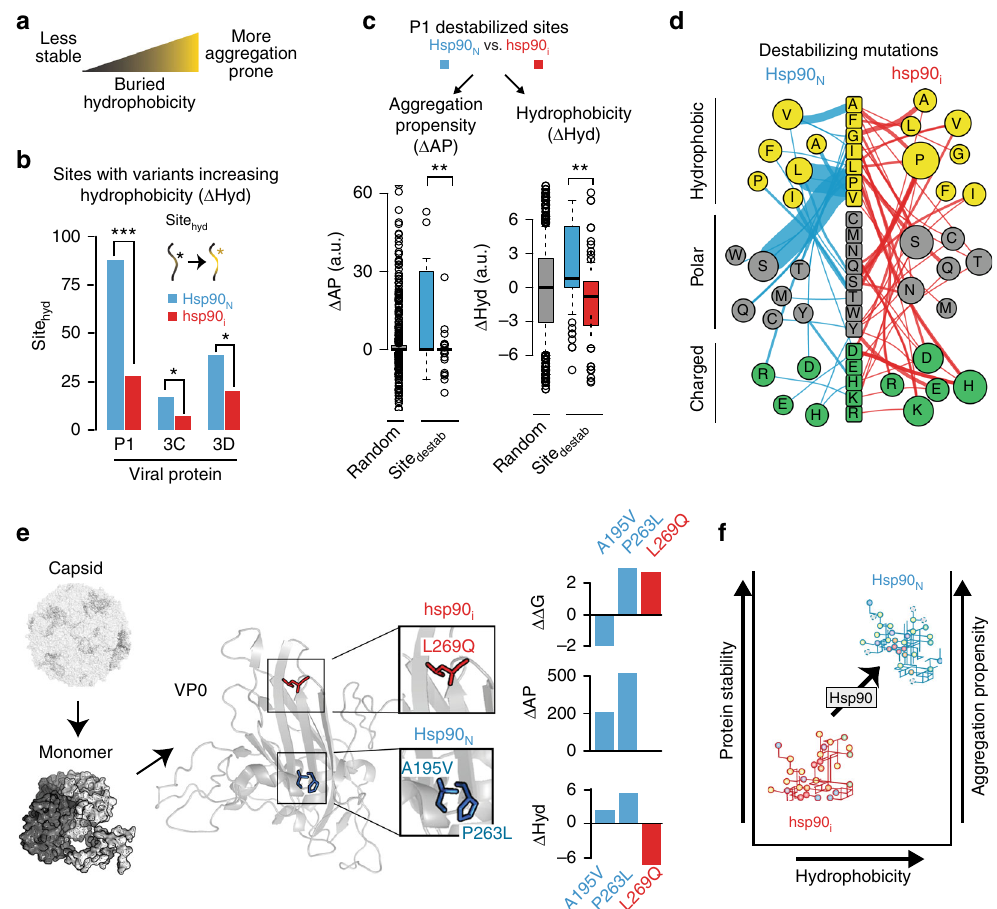
Fig. 4 Hsp90 mediates a trade-off between stability and aggregation propensity. a Effect of buried hydrophobicity on protein stability and aggregation propensity. b Sites with increased hydrophobic variants (Site hydro ) in Hsp90 N and hsp90 i populations. c Properties of P1 destabilized sites (Site destab ) from Hsp90 N and hsp90 i : aggregation propensity (left panel) and hydrophobicity (right panel). d Distinct nature of destabilizing variants (Site Hsp90 hsp90 N and i populations. Original amino acid is indicated in the middle. Color indicates side-chain properties: Yellow, hydrophobic; gray, polar; green, charged. Mutations to speci fi c residues in Hsp90 N (left) and hsp90 i (right) are indicated, where circle size indicates mutation occurrence. The width of lines connecting each mutation represents the number of occurrences for each variant. e Exemplar P1 variants enriched in Hsp90 N and hsp90 i populations. Location in P1 folded structure and effects on stability, aggregation propensity, and hydrophobicity are indicated. Mutations A195V and P263L (blue) observed in Hsp90 N , and L269Q (red) in hsp90 i . Structure from 2PLV, with VP2 monomer, and assembled capsid indicated. f Schematic effect of Hsp90 on sequence space. Hsp90 allows variants to explore a region in sequence space of increased hydrophobicity and aggregation propensity, but also of increased stability. Lower Hsp90 constrains sequence space variants to a region of reduced stability, hydrophobicity, and aggregation propensity. For boxplots, the center line represents the median, the bound box the interquartile range, and the whiskers 1.5× the interquartile range. Signi fi cance: * p < 0.05; ** p < 0.01; *** p < 0.005 by two-tail Fisher ’ s exact test or Mann – Whitney – Wilcoxon